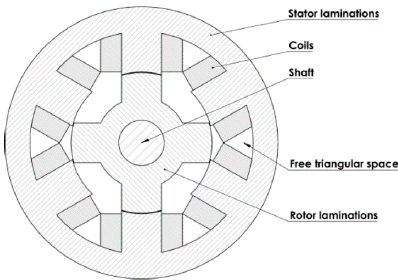
Figure 3. 2D cross-section of the machine, a stator segment of which is used as the test case in this study. Table 1. Geometrical dimensions of the machine.